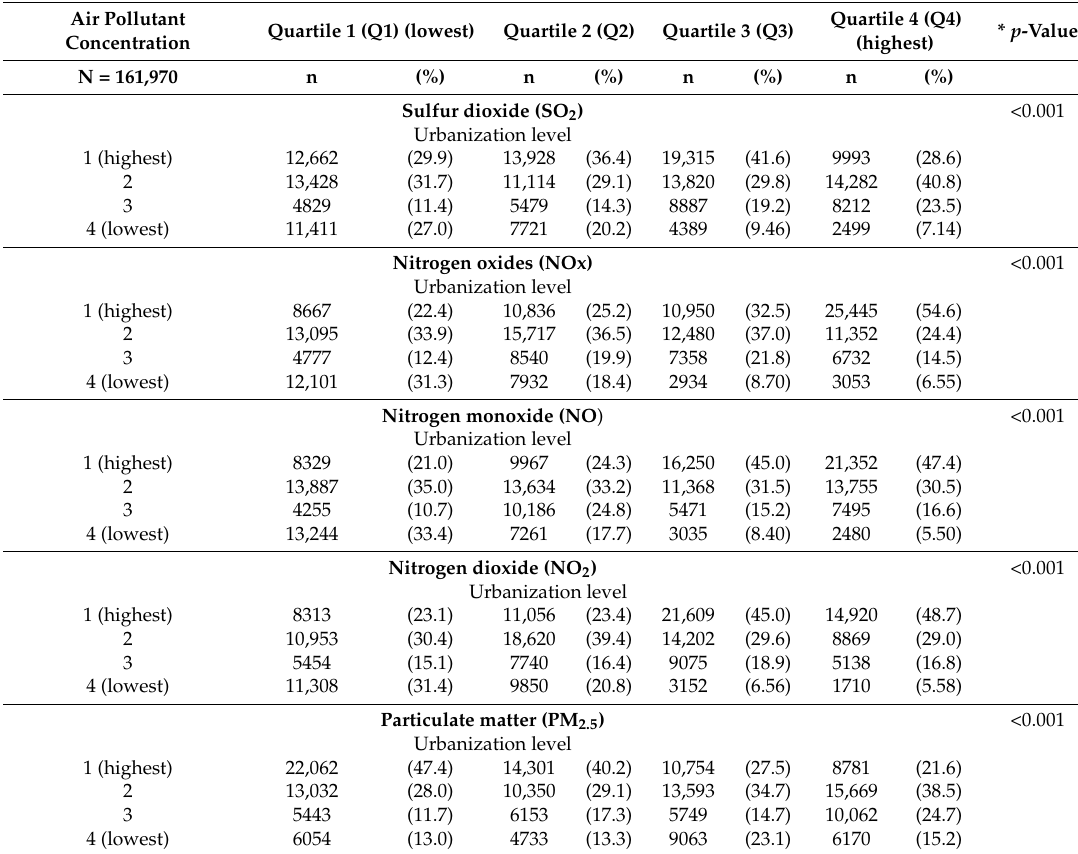
Table 2. Baseline urbanization level among quartiles of daily average concentration of air pollutants in